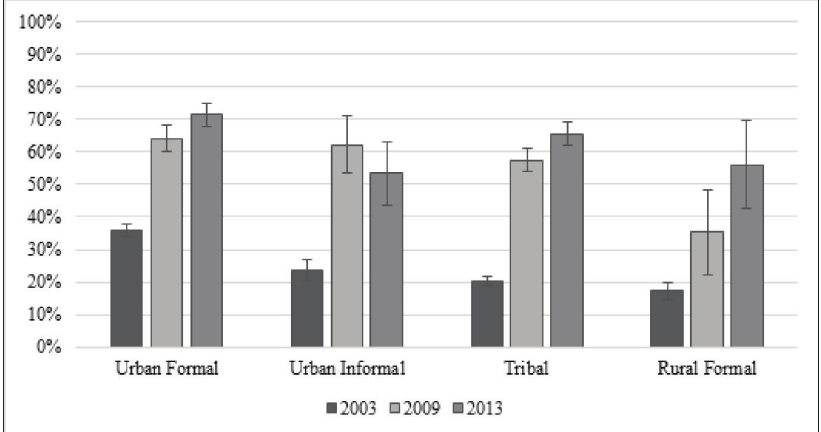
Figure 4: ECD participation of four-year-olds by geographical area (Source: SSA